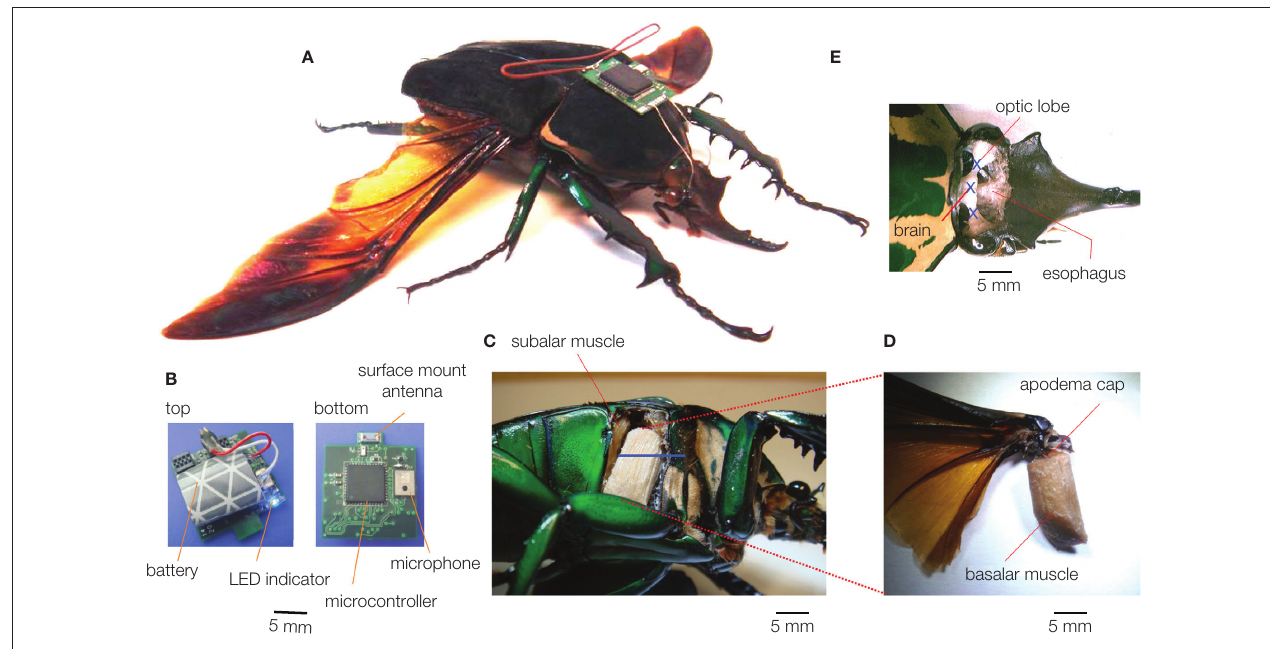
FIguRe 1 | A beetle hybrid system (Sato et al., 2009b; Maharbiz and Sato, 2010). (A) Overview of the stimulator-mounted beetle (Mcynorhina torquata, 6 cm, 10 g, 3 g payload capacity). (B) The latest version of beetle stimulator. It has a surface mount ceramic antenna, and its total mass is 1.22 g (a lithium ion